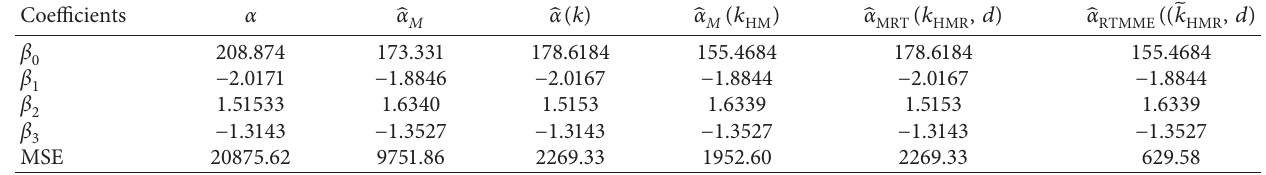
Table 19: Estimated MSE values of the OLSE, ME, RE, RME, MRT, and RTMME in Hussein data set. Coefficients α 􏽢 α